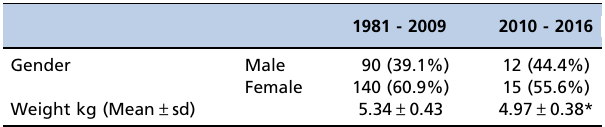
Figure 2 - Final aspect of the surgery. Note the Roux-en-Y jejunal loop draining the transected porta hepatis . Table 1 - Demographic data of patients from the two study